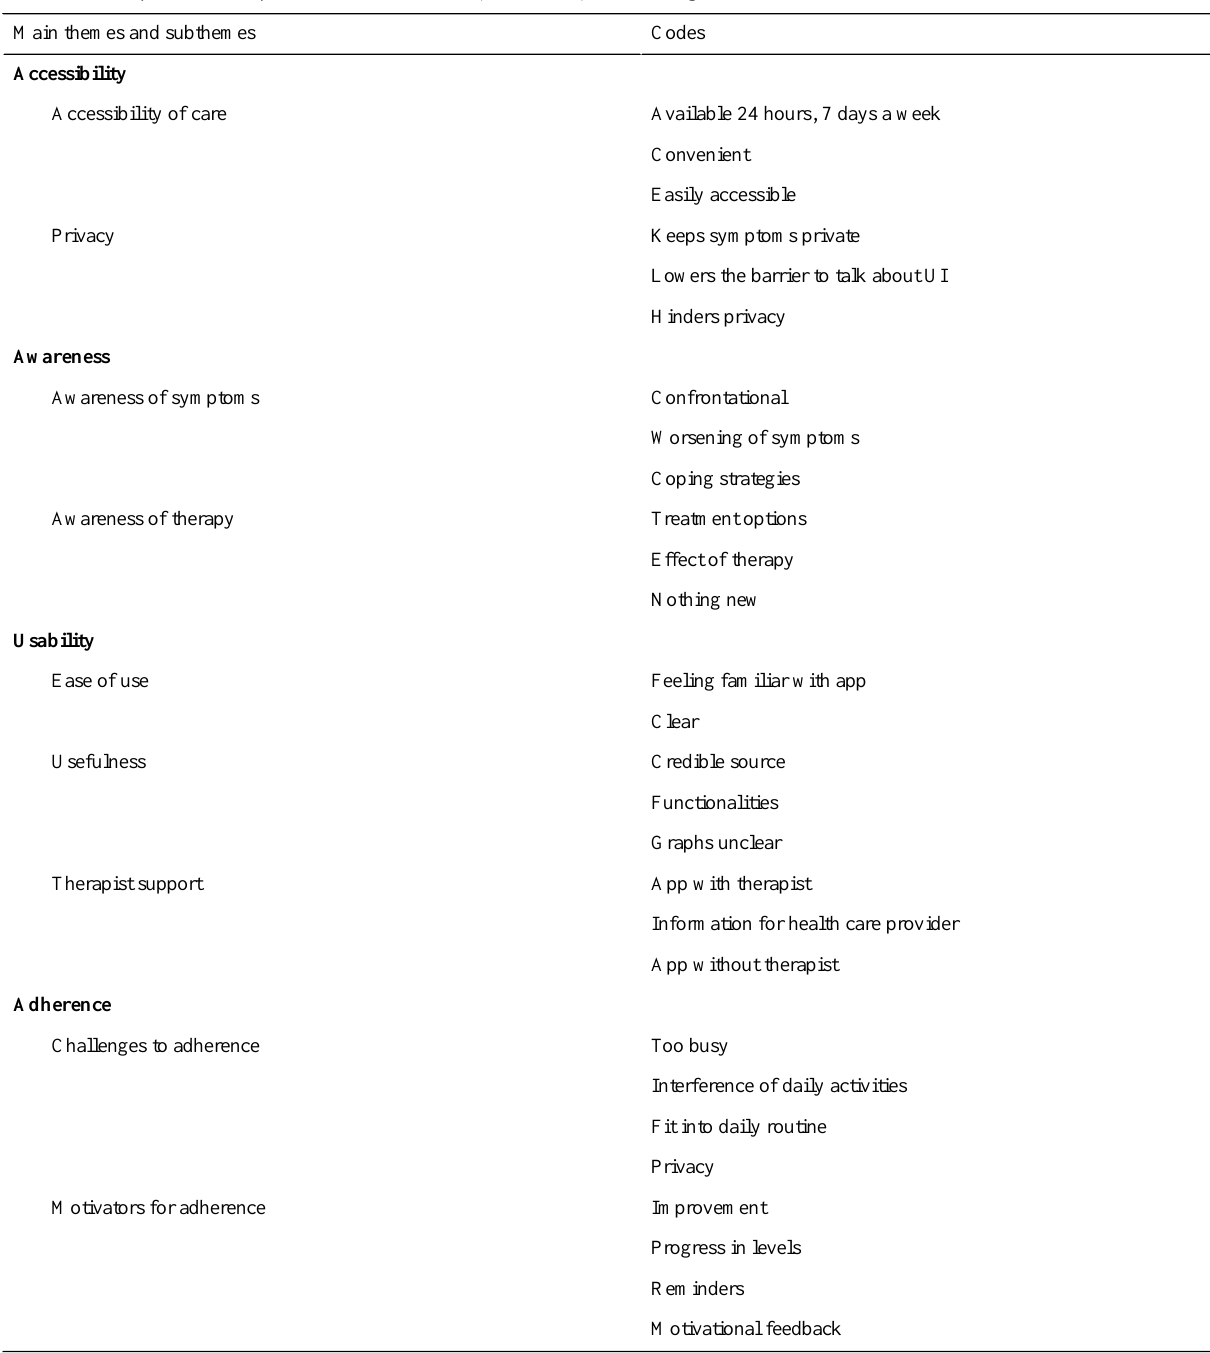
Table 3. Participants' themes presented as main themes, subthemes, and meaningful